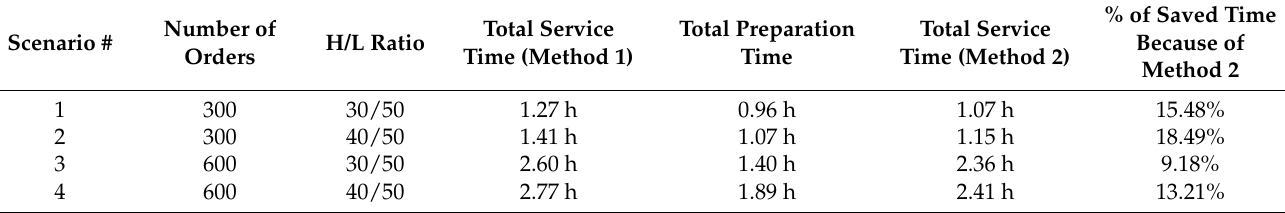
Table 5. General results for different scenarios.